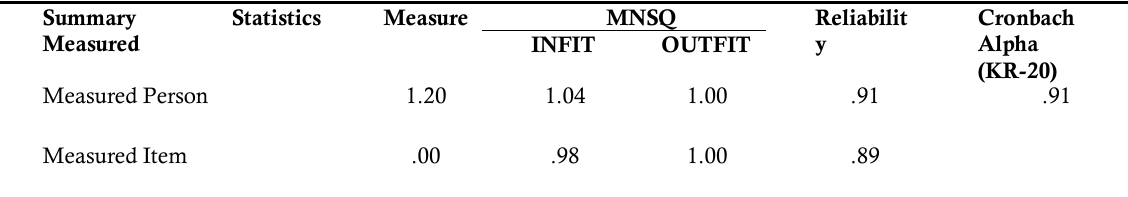
Table 5. Summary Statistics Measured Person and